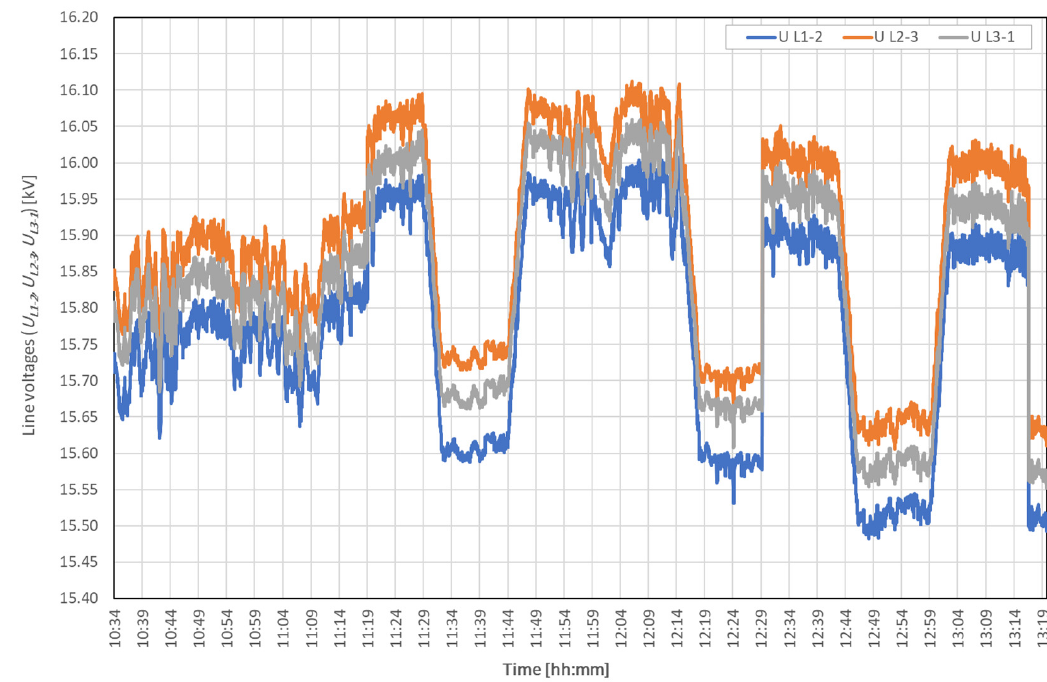
Figure 6. Time course of the values of the line voltages at the connection point of a wind power plant. The variation curves of the values of the voltage asymmetry coefficients are shown in Figure 7—zero asymmetry coefficient ( k U 0 ) and Figure 8—opposite asymmetry coefficient ( k U 2 ).